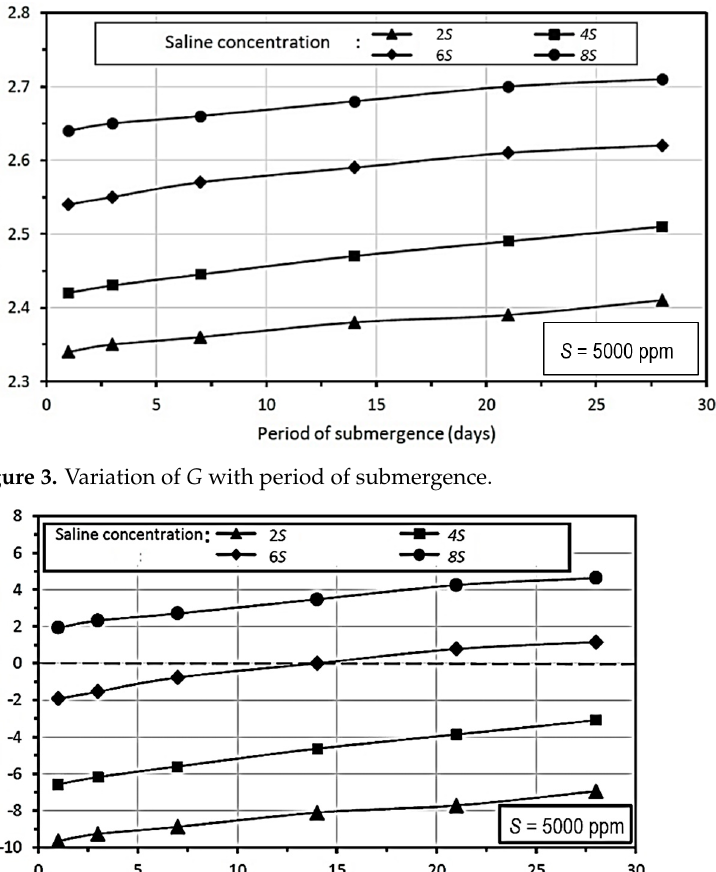
Figure 5. Variation of specific gravity with saline concentration. Figure 6. Variation of percentage increase in the value of G with saline concentration.